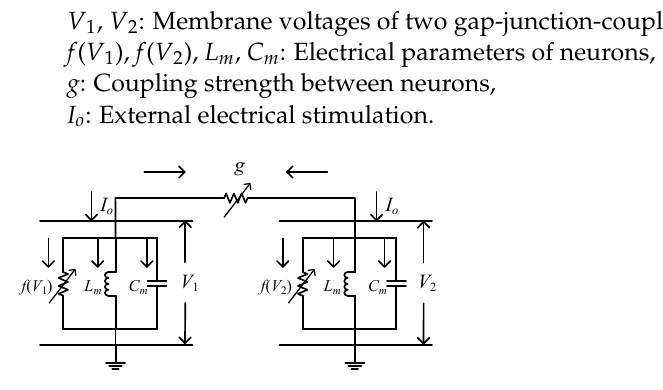
V 1 , V 2 : Membrane voltages of two gap-junction-coupled neurons,